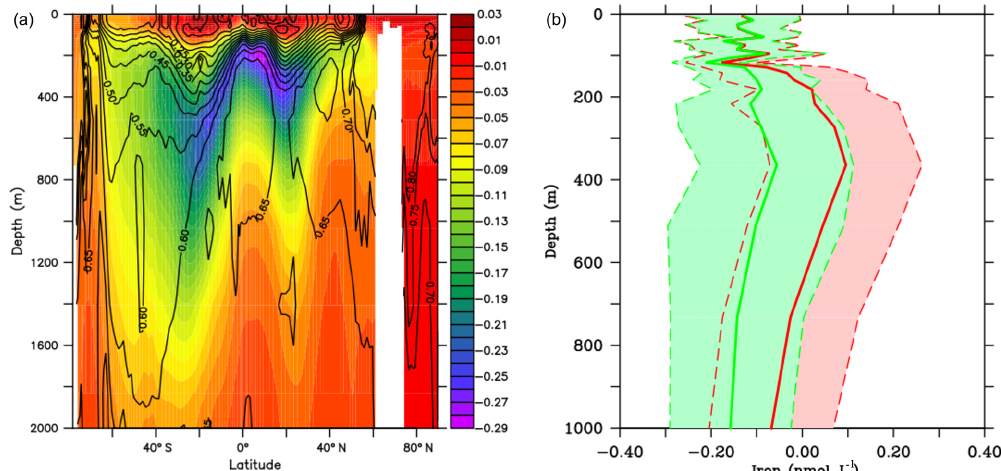
Figure 11. Iron distribution (nmolFeL − 1 ) in the Pacific Ocean. The left panel shows the zonal average of the difference between the RC and the noRC experiments. The isolines display the zonally averaged iron distribution as simulated in the noRC experiment. The right panel shows the vertical profiles of the difference between the simulated iron distributions (red solid line: the noRC experiment; green solid line: the RC experiment) and observed iron from Tagliabue et al. (2012). Differences have been averaged over the Pacific Ocean. The light shaded areas display the standard deviation of the differences (red: the noRC experiment; green: the RC